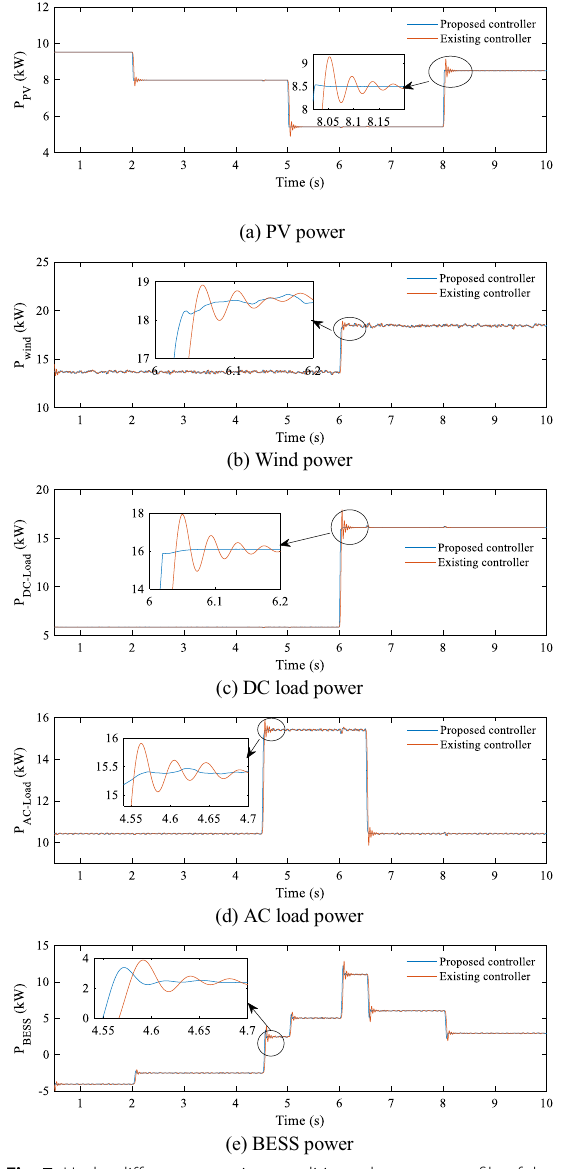
Fig. 7 Under different operating conditions, the power profile of the a solar PV unit, b wind generator, c DC load, d AC load, and e BESS